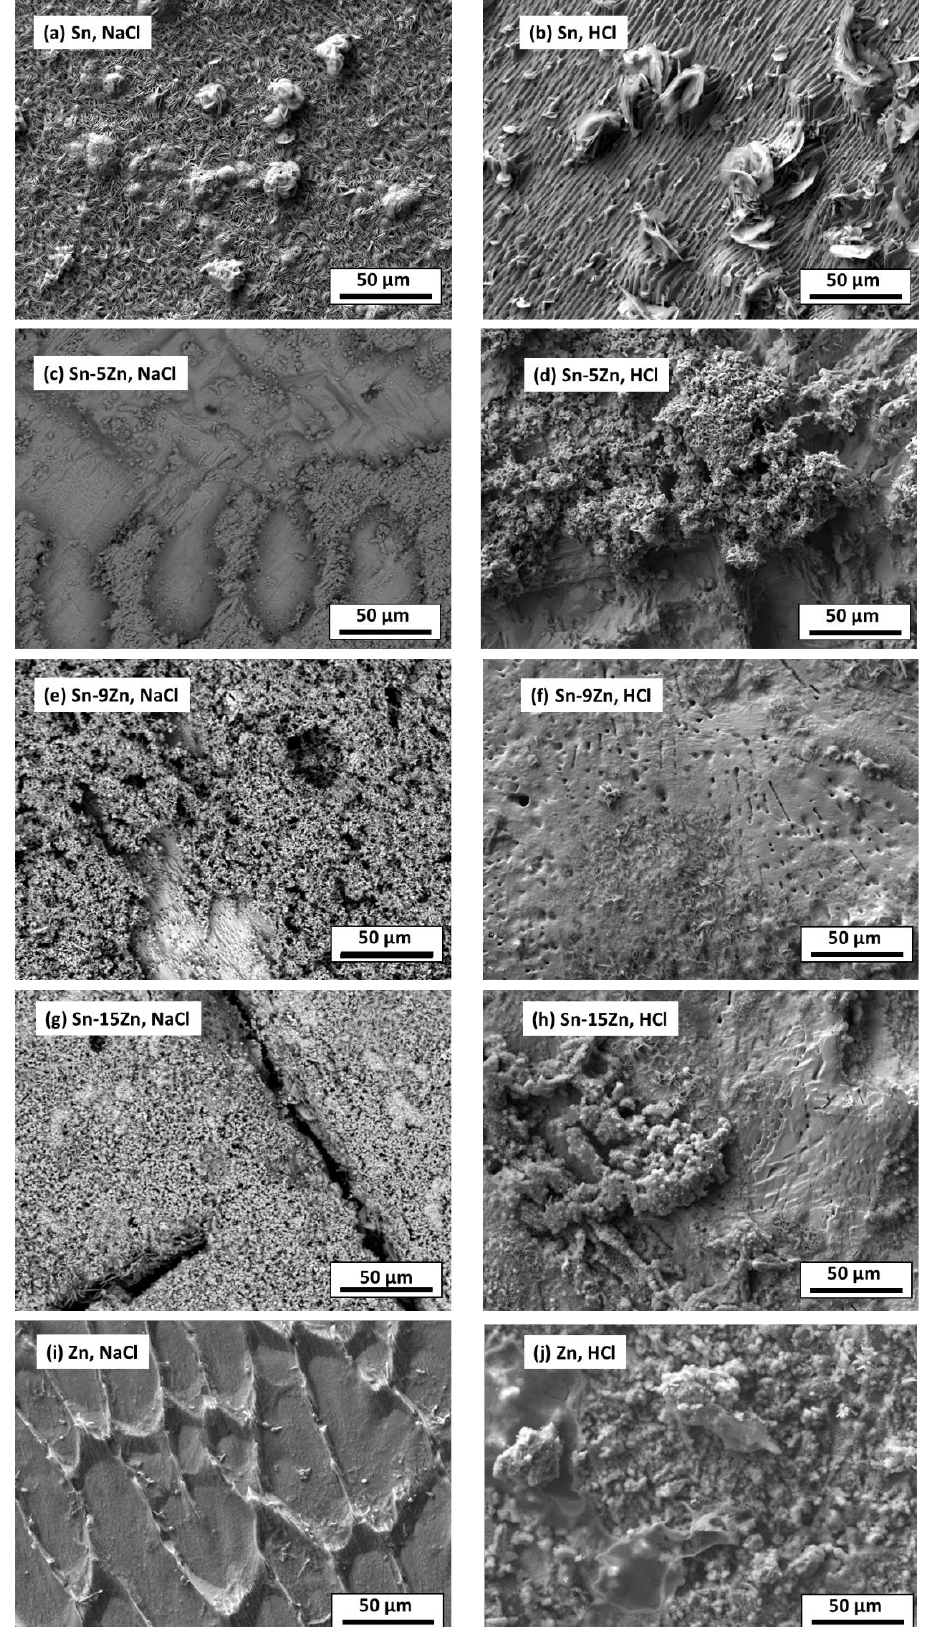
Figure 9. Microstructure of Sn – xZn alloys after corrosion in NaCl ( a , c , e , g , i ) and HCl solutions ( b , d , f , h , j ).